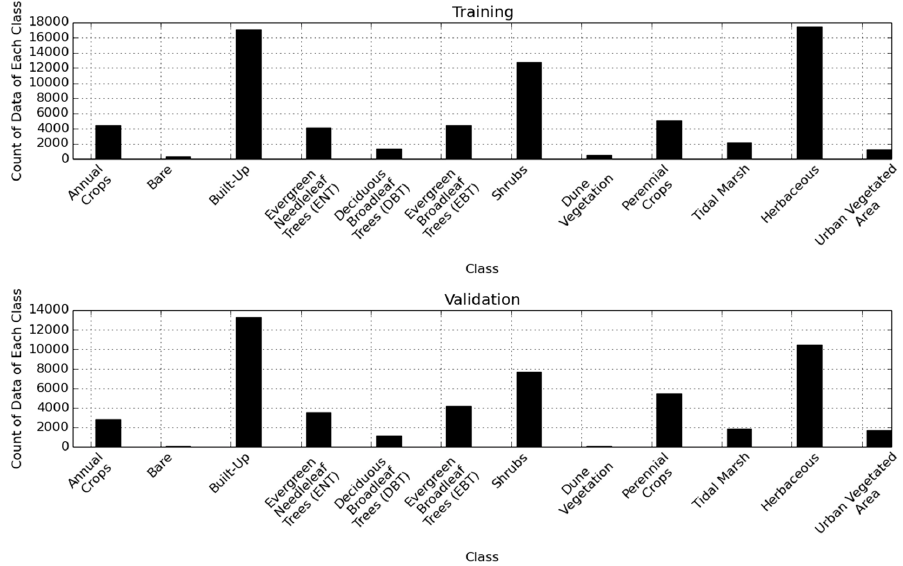
Figure 3. Training and testing reference data distributions.